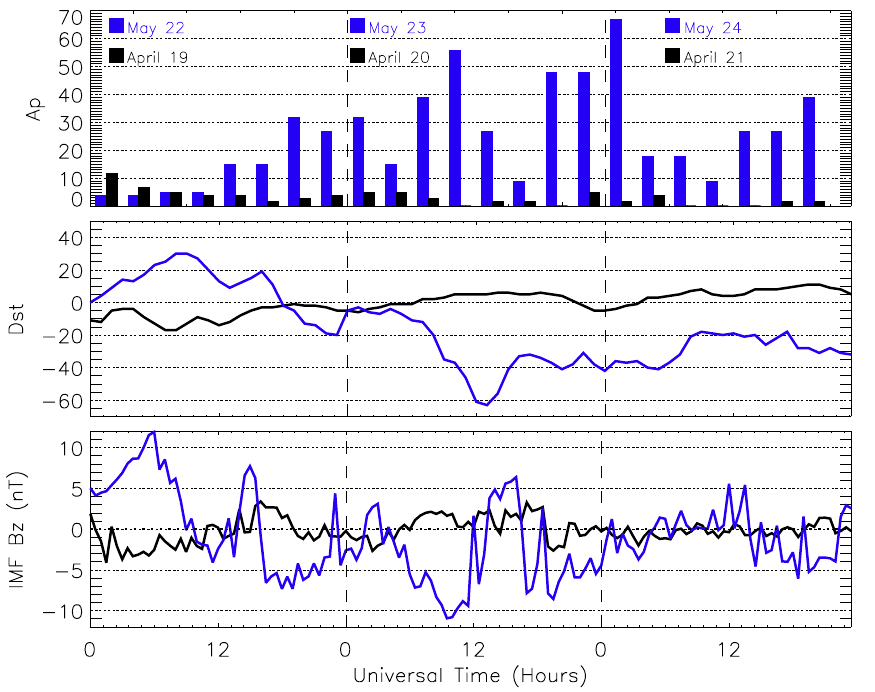
Fig. 3. Geomagnetic conditions for the 3-day periods centered on nights A and B. Night A (20 April) is shown in black, night B (23 May) in